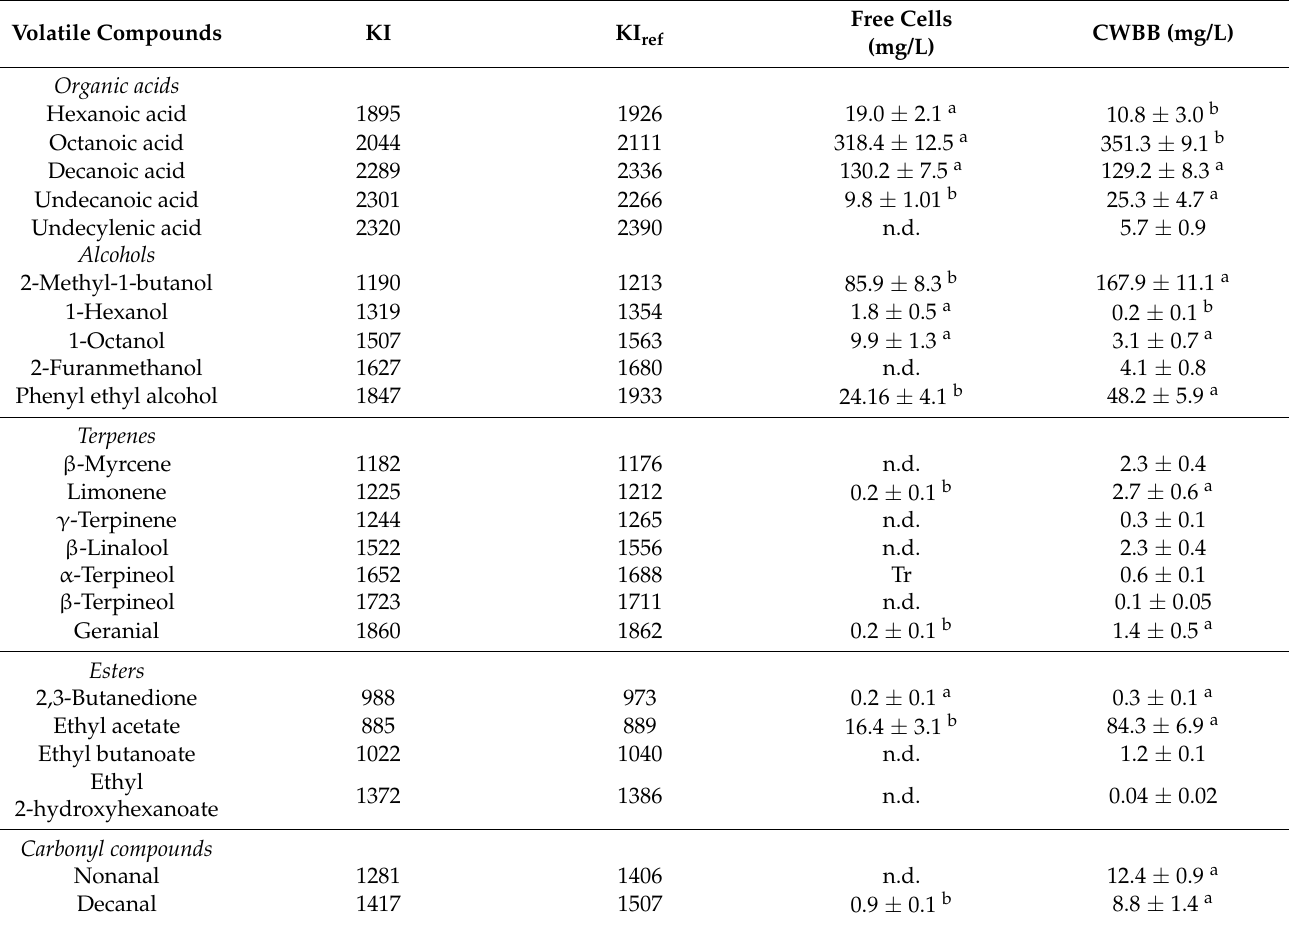
Table 2. Volatile compounds detected in the beers brewed at 10 ◦ C using the CWBB or free yeast